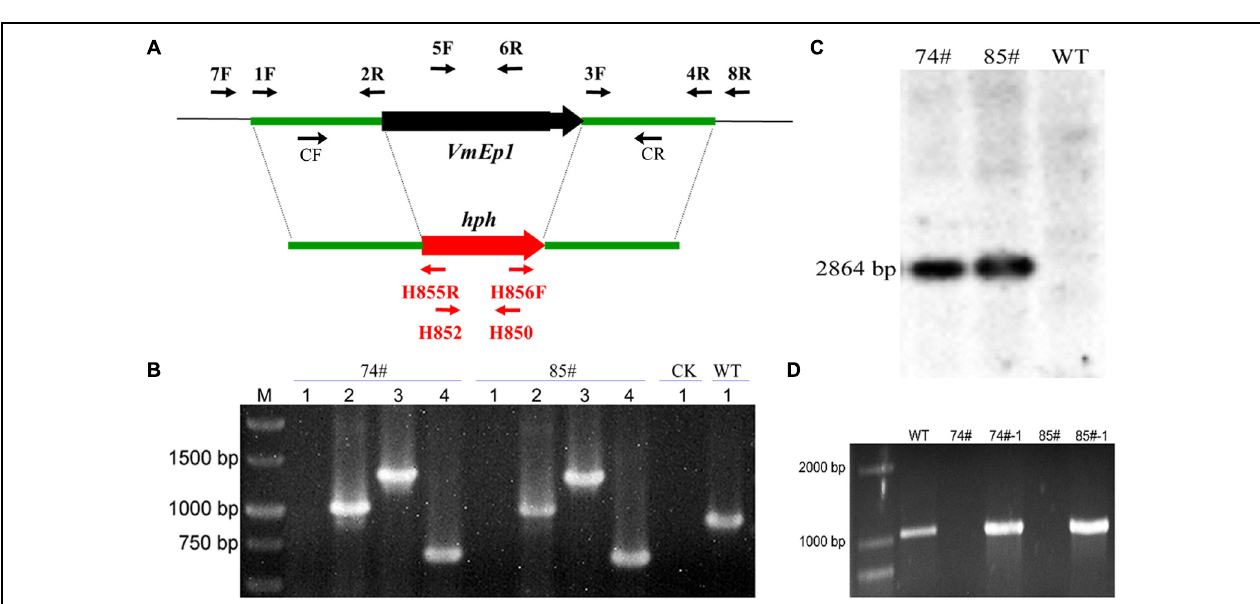
mutants by PCR analysis. 1–4 primer pairs: (1) VmEP1-5F/6R (targeted gene), (2) VmEP1-7F/H855R upstream region), (3) VmEP1-H856F/8R (downstream region), and (4) H850/H852 ( hph cassette). (C) Southern blot hybridization analysis of VmEp1 mutants using primer H850/H852. (D) Identification of VmEp1 complementation mutants by PCR analysis using primer pair VmEP1-5F/6R.